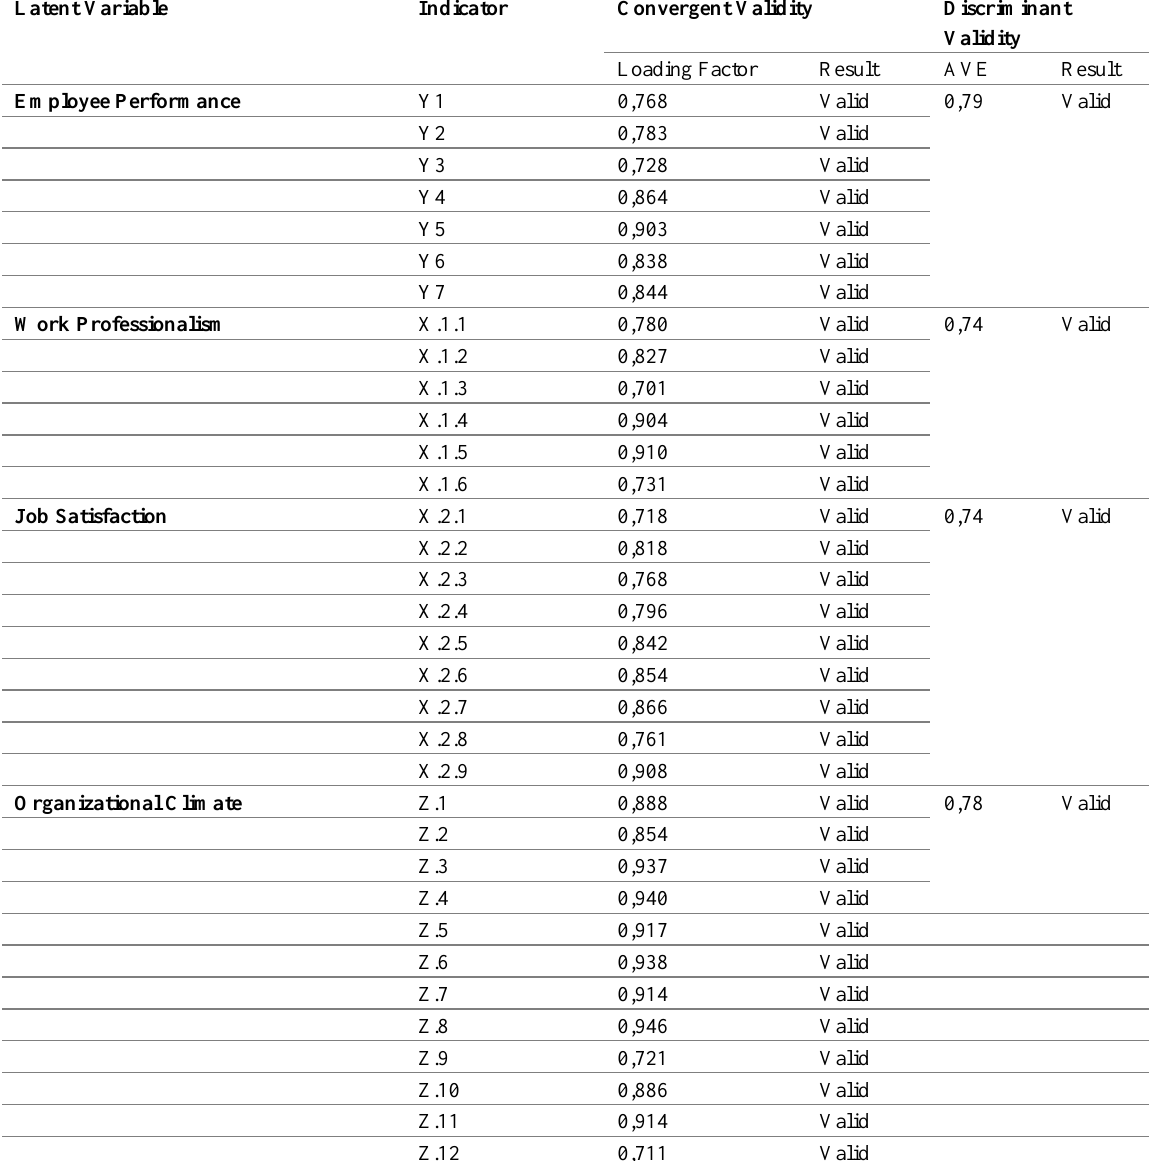
Table 3: Validity